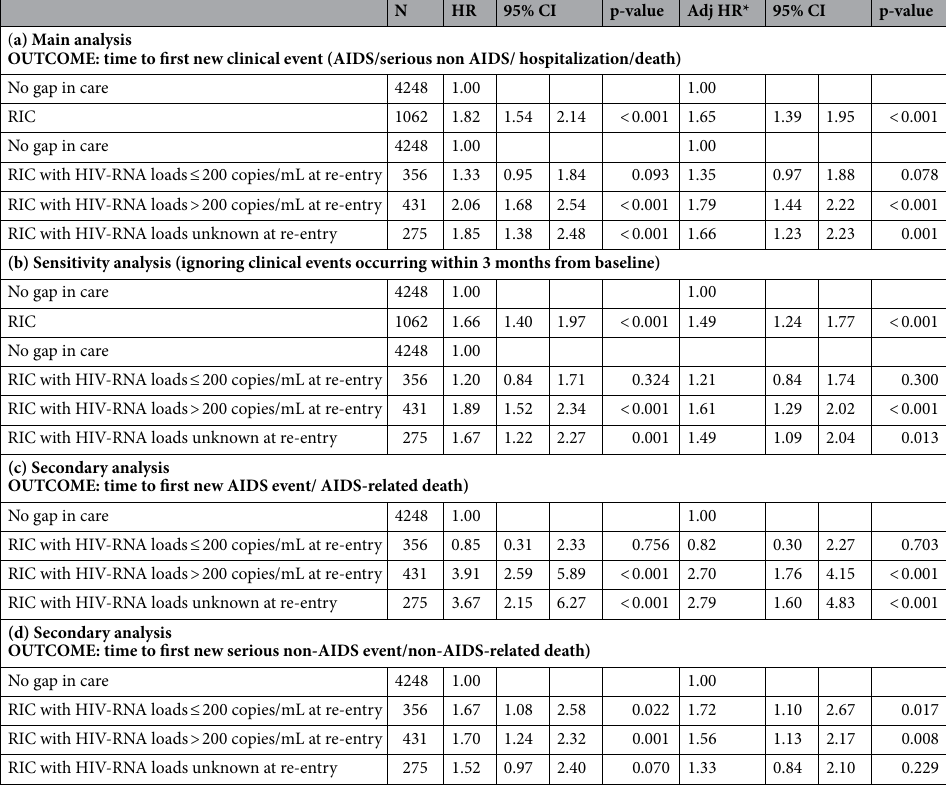
Table 6. Crude and adjusted Hazard Ratio (adj HR) and relative 95% confidence interval (CI) of first new clinical event (AIDS/serious non AIDS/hospitalization/death) in the main analysis (a), in the sensitivity analysis (b). Two secondary analyses estimating risk of AIDS event/AIDS-related death (c) and risk of serious non-AIDS event/non-AIDS-related death (d). * Models were adjusted for: gender, risk factor for HIV transmission, Italian nationality, employment status and level of education, and for the following covariates measured at last follow-up before gap in care: HCV-Ab result, CDC C stage, CD4 count and HIV-RNA, presence of psychiatric co-morbidity and alcohol and/or drug abuse.